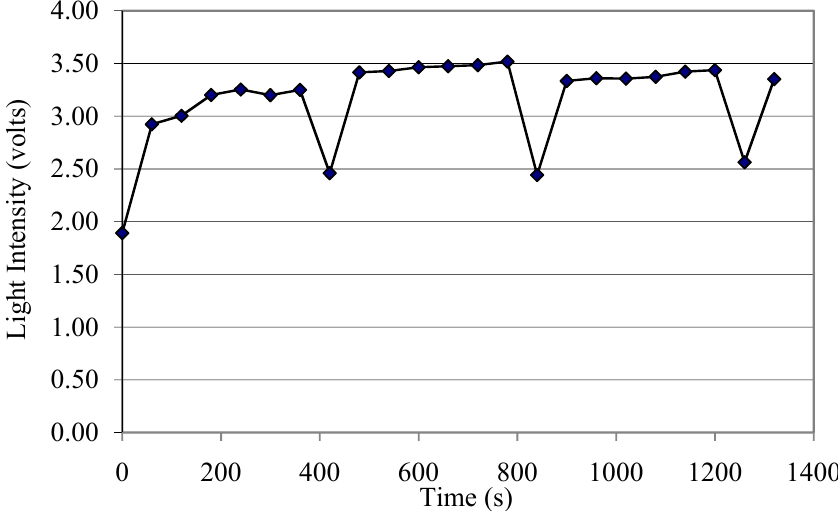
Figure 3. Wenglor® optical sensor signal after cleaning with CO seconds during abrasive